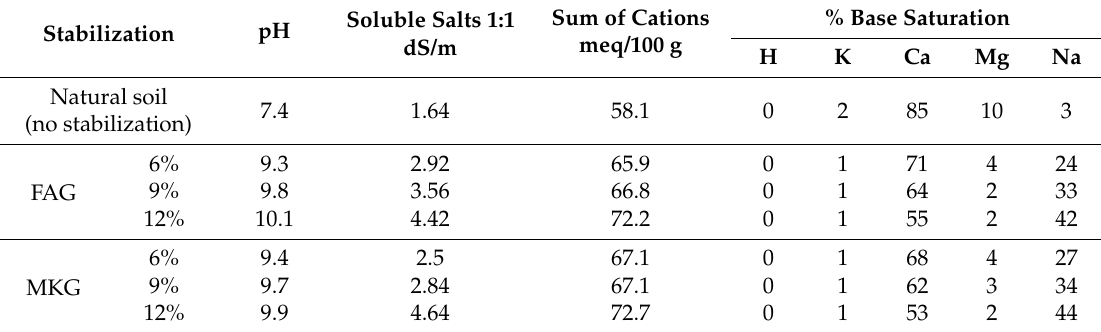
Table 3. The pH, soluble salts, cation exchange capacity (CEC), and base saturation percentage for soils treated with different amounts of FAG and